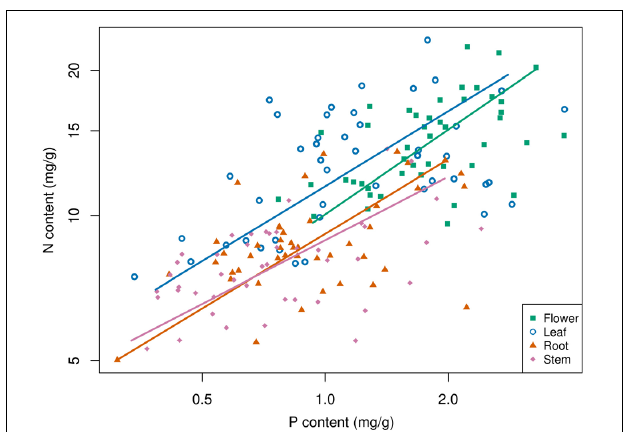
FIGURE 3 | Relationships between N and P in different plant organs. A base-10 logarithmic scale is used for the axes. The sample size is 45 for each plant